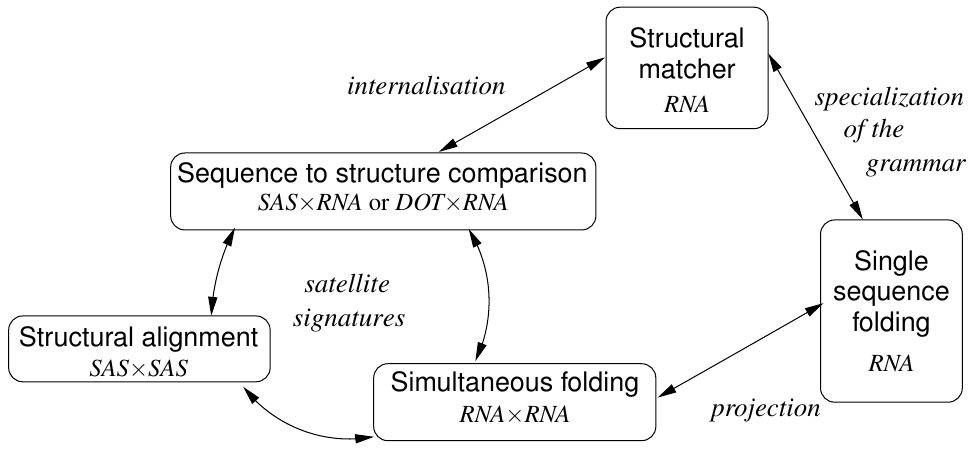
Figure 9. Relationships between our five main RNA